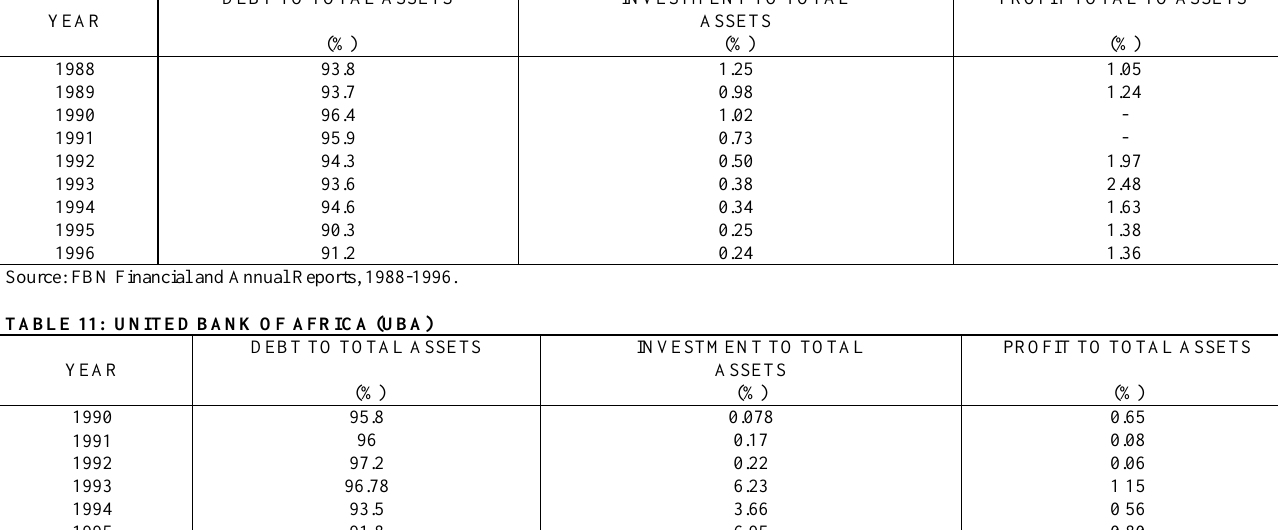
TABLE 10: TREND ANALYSIS OF RATIOS IN PRIVATISED BANKS FIRST BANK NIGERIA PLC YEAR